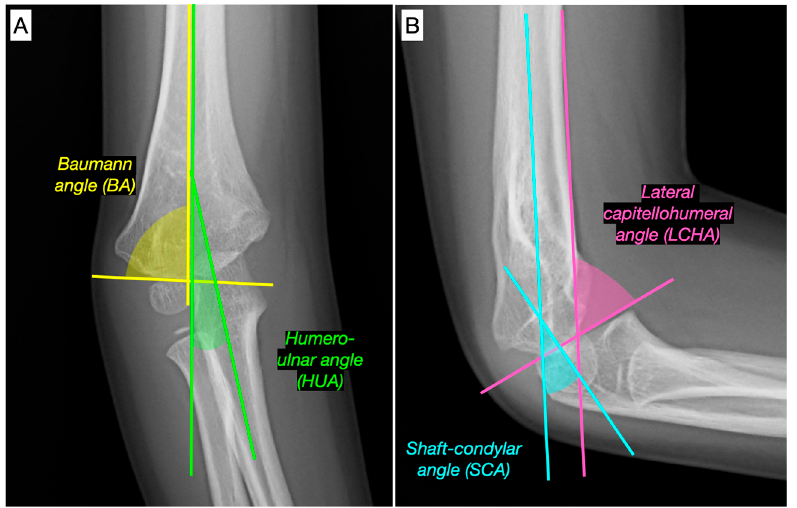
Figure 3. Radiologic measurements on anteroposterior ( A ) and lateral ( B ) elbow radiographs. BA, Baumann angle; HUA, humero-ulnar angle; SCA, shaft-condylar angle; LCHA, lateral capitello- humeral angle.